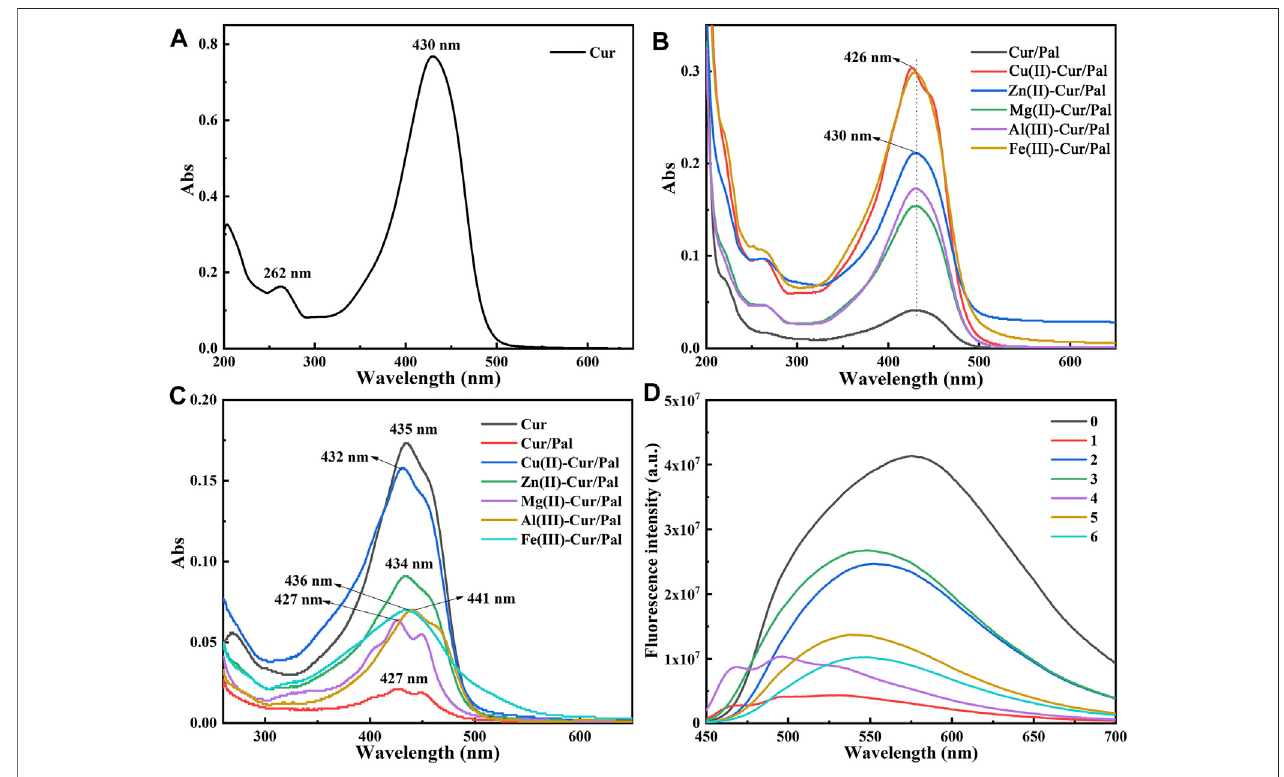
FIGURE5| UV-spectra ofCur,Cur/Pal and metal ions-Cur/Pal hybrid materials dissolved in80% ethanol/water solution (A,B) and in DMSO (C) . (D) Fluorescence emission spectra of the above samples [0: Cur; 1: Cur/Pal; 2: Cu(II)-Cur/Pal; 3: Zn(II)-Cur/Pal; 4: Mg(II)-Cur/Pal; 5: Al(III)-Cur/Pal; 6: Fe(III)-Cur/Pal].